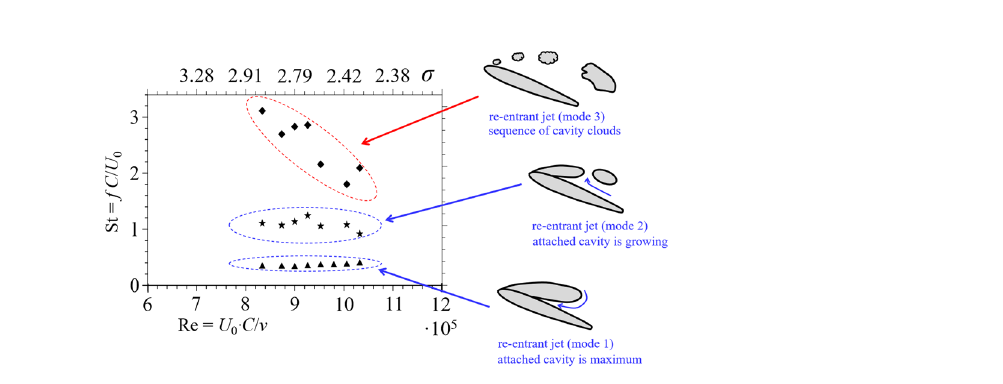
Figure 6. The first three most energetic modes of DMD analysis for cavitation flow around a NACA0012 hydrofoil. σ = 2.41.